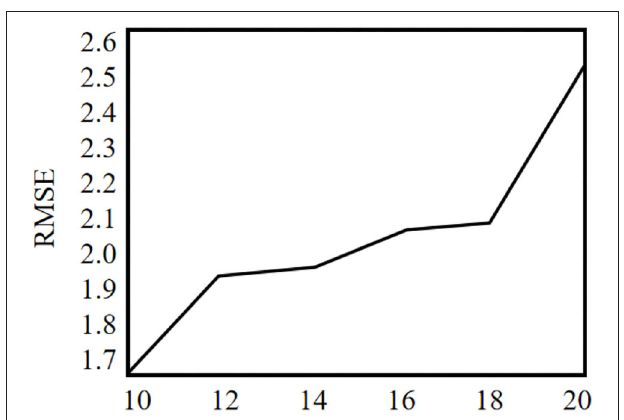
FIGURE 10 | The effect of hash tables number on the RMSE value.